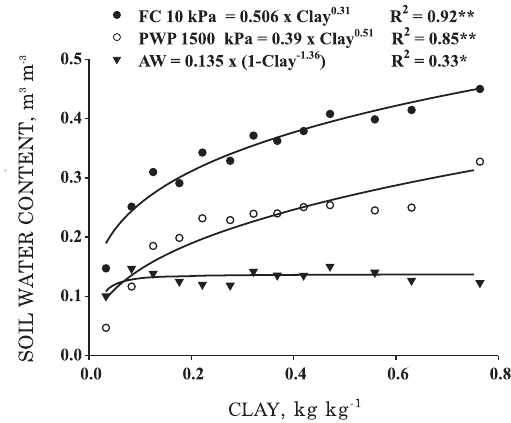
Figure 7. Relationship between the clay content in the soil and the water content at field capacity (FC = 10 kPa), at the permanent wilting point (PWP = 1,500 kPa) and the plant-available water capacity (AW = different between water content at 10 and at 1,500 kPa) for the RS